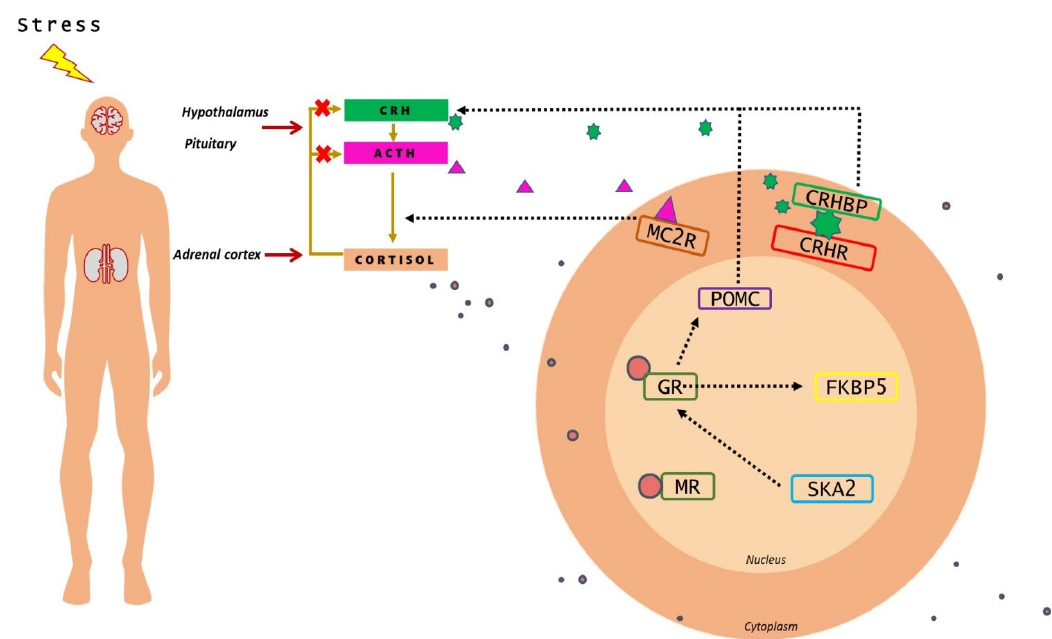
Figure 1. Representative image of HPA axis and the stress pathway genes implicated in suicide behavior. Upon perception of stress, CRH is released from the hypothalamus, which promotes the synthesis and release of ACTH from the pituitary. ACTH, in turn, increases the release of cortisol from the adrenal glands. Through negative feedback, cortisol inhibits the hormone release from the hypothalamus and anterior pituitary glands. Inside the cell, cortisol causes the activation of molecular mechanisms that regulate the impact of the HPA axis.